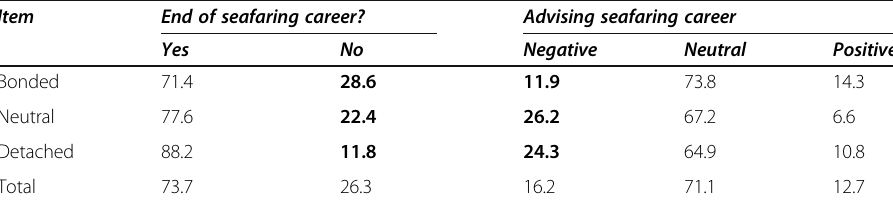
Table 9 Planning to end of, or advising seafaring career by bonding (%) Item End of seafaring